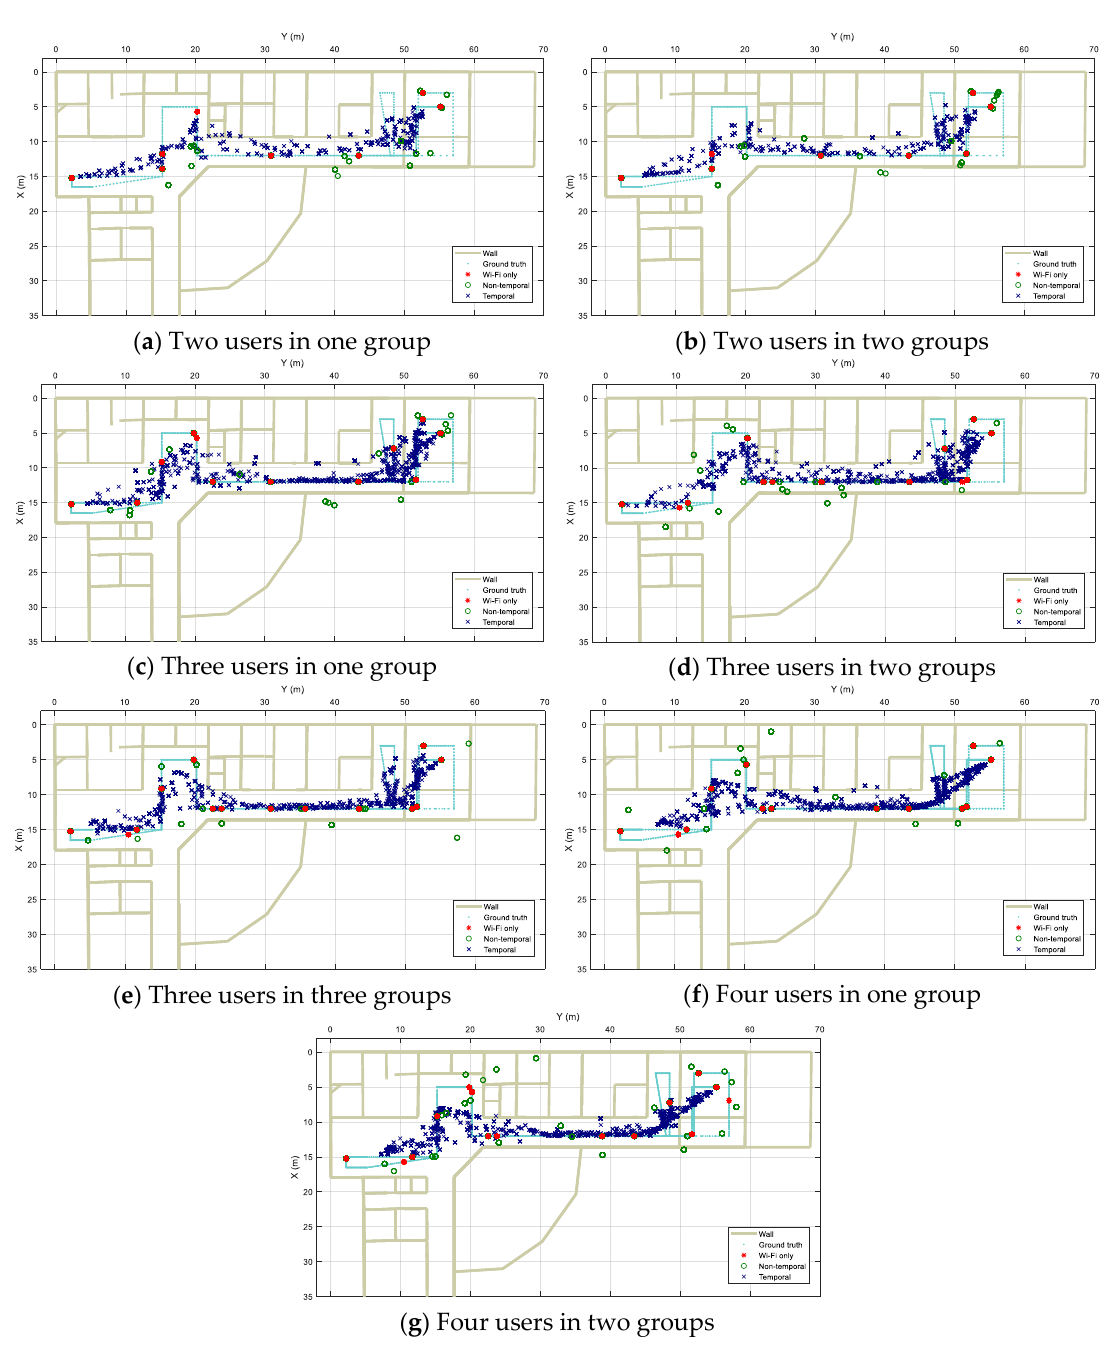
Figure 12. Localization results for designed scenarios. ( a ) Two users walking together in single group. ( b ) To users walking separately. ( c ) Three users walking all together in single group. ( d ) Three users walking where two are in group and another separately. ( e ) Three users walking separately. ( f ) Four users walking all together in single group. ( g ) Four users where each two walking together in